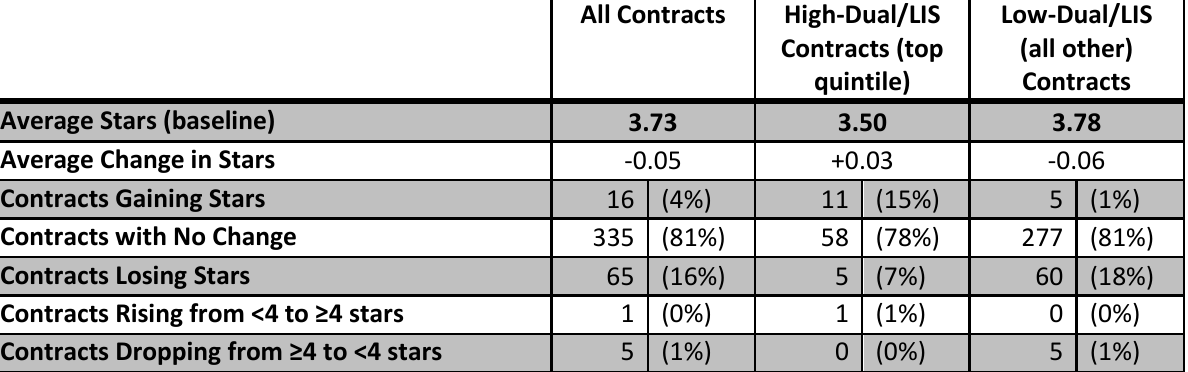
Table 8.12: Adjusting Individual Measures using Population Grouping (via Indirect Standardization) All Contracts High-Dual/LIS Low-Dual/LIS Contracts (top (all other) quintile) Contracts Average Stars (baseline) 3.73 Average Change in Stars -0.05 Contracts Gaining Stars 16 Contracts with No Change (81%) Contracts Losing Stars 65 (16%) (18%) Contracts Rising from <4 to ≥4 stars 1 (0%) (0%) Contracts Dropping from ≥4 to <4 stars